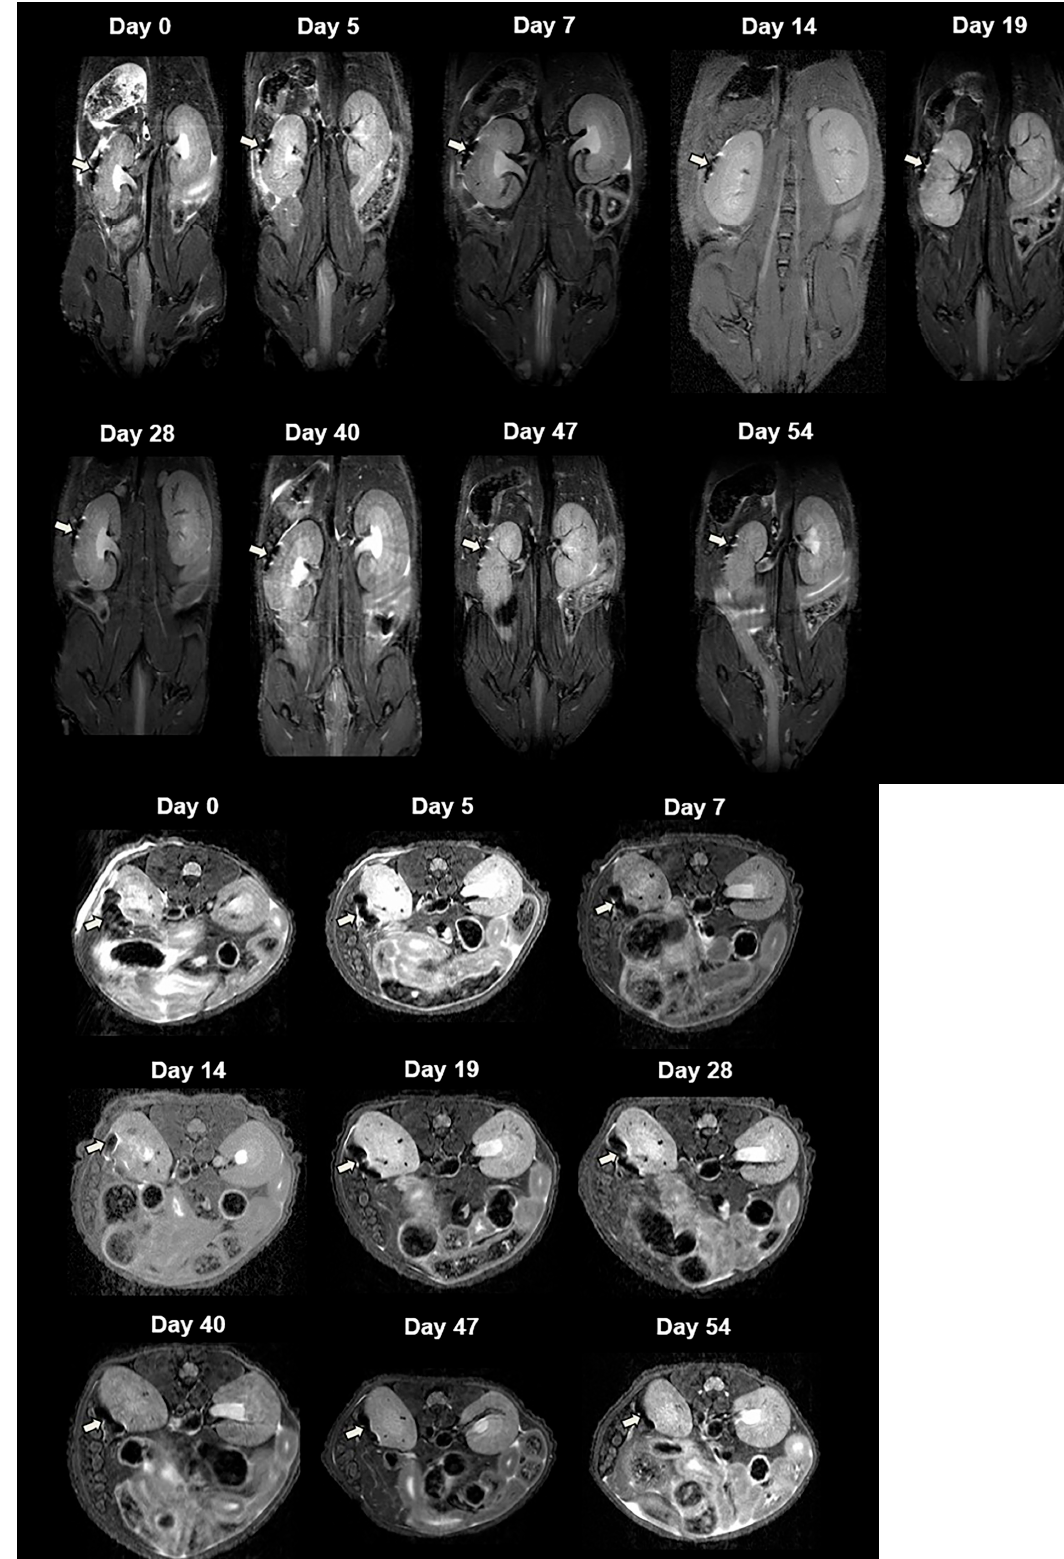
Figure 3. In vivo MR image of NPCCs after transplantation. Two thousand CSPIO-labeled NPCCs were transplanted under the left kidney capsule of a nude mouse. The recipient was scanned by a 7.0 T MRI system with coronal (upper panel) and transverse (lower panel) sections. The graft of CSPIO-labeled NPCCs was indicated by arrows.